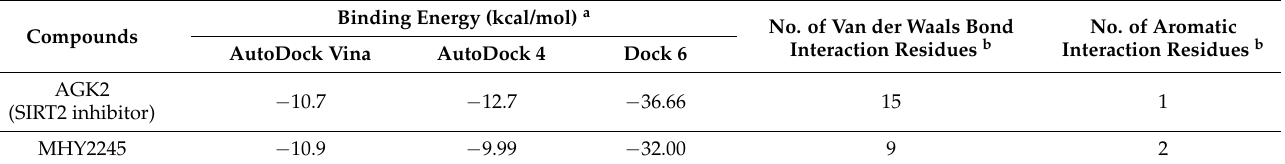
Table 2. Docking simulation to identify the interactions between the ligand-binding domains of SIRT2 and